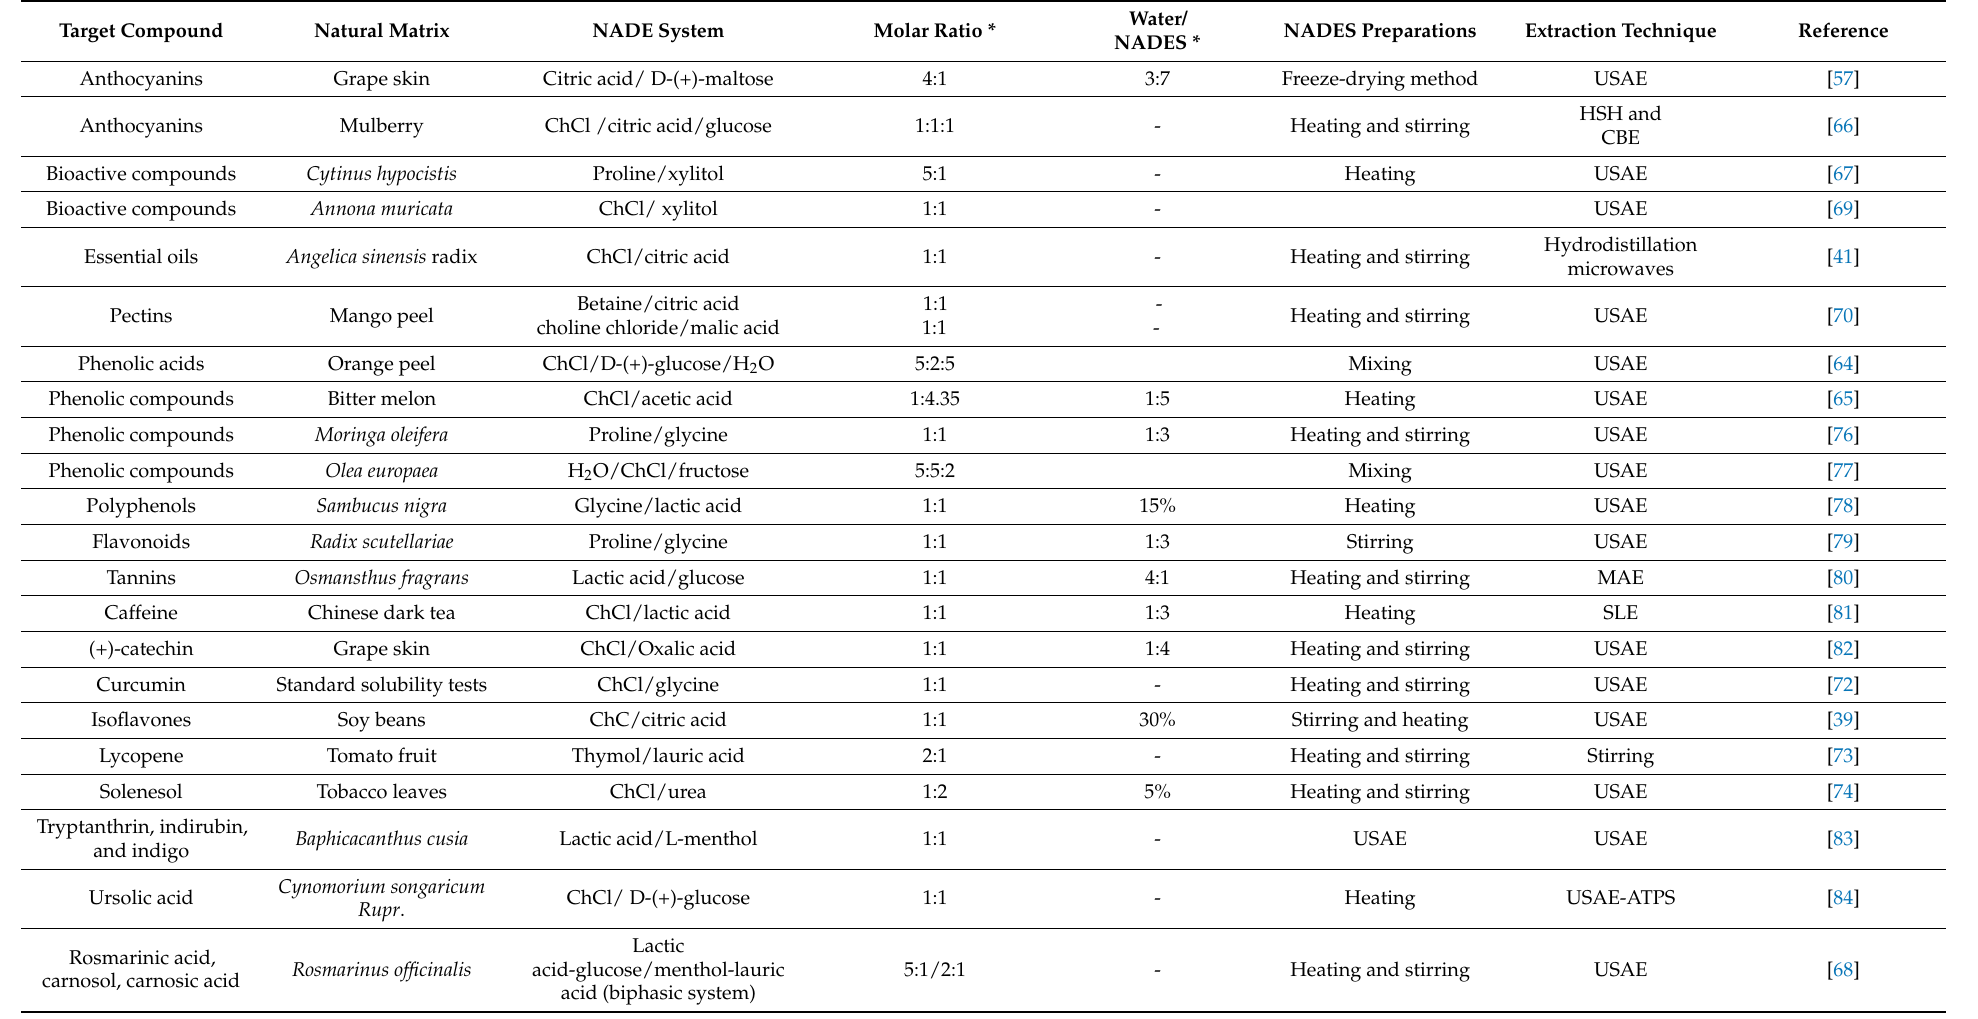
Table 2. Extraction of target compounds from food matrices by using NADES and combined extraction